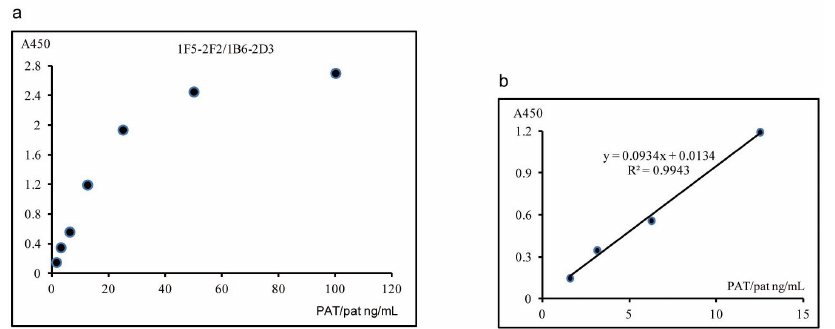
Figure 4. Specificity of anti-PAT/pat mAbs. ( a ) SDS-PAGE stained with Coomassie Blue, protein